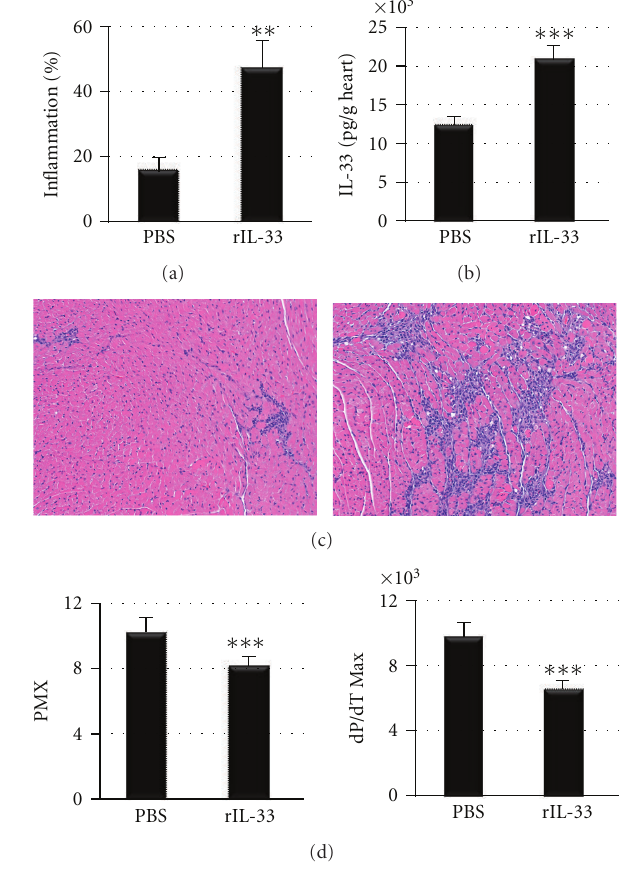
Figure 8: Recombinant IL-33 treatment increases myocarditis and cardiac dysfunction in BL/6 mice. Male BL/6 mice were treated with recombinant IL-33 (rIL-33) or PBS every other day from day 1 to 9 pi and (a,c) myocarditis, (b) cardiac IL-33 levels by ELISA and (d) heart function assessed using pressure-volume relationships at day 10 pi. (c) Representative histology sections of inflammation in PBS-treated (left) and rIL-33-treated (right) BL/6 mice stained with H&E, magnification × 64. Data show the mean ± SEM of 10 mice/ group. ∗∗ : P < 0 . 01; ∗∗∗ : P < 0 .